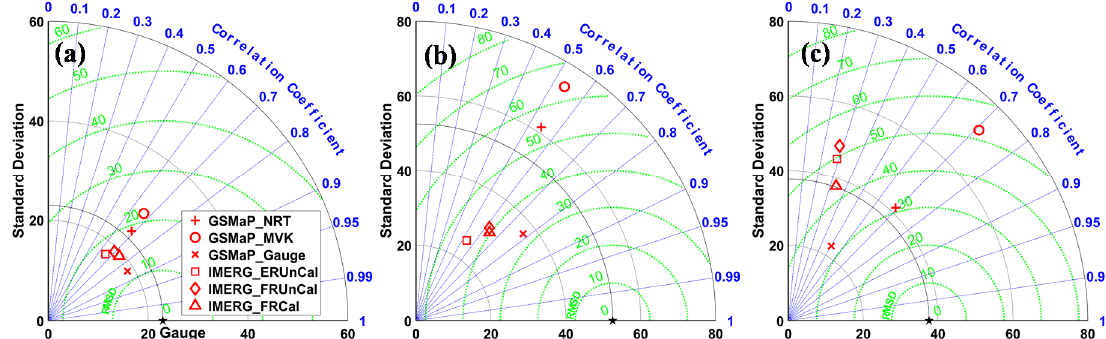
Figure 4. Taylor diagrams with correlation coefficients, standard deviation (normalized), and root-mean-squared deviation (RMSD also means RMSE) of 72 h of accumulated precipitation between the satellite-based precipitation products and the reference data over ( a ) mainland China and the rainfall centers in ( b ) southern China and ( c ) eastern China.